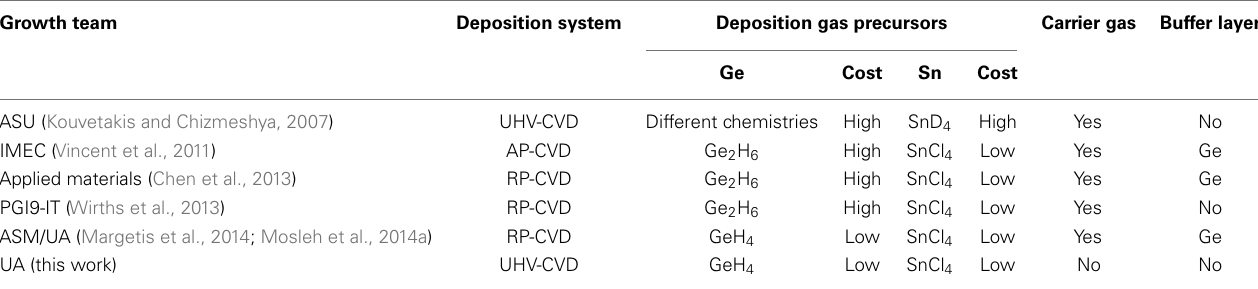
Table 1 |A summary of reports on Ge 1 − x Sn x growth using CVD methods by different research groups